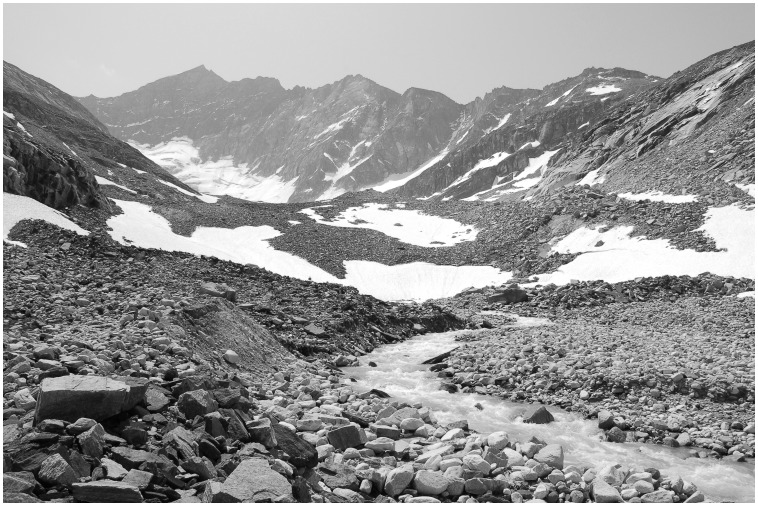
Ödenwinkelkees river sampling site.Stream width in the foreground is approximately 5 m.